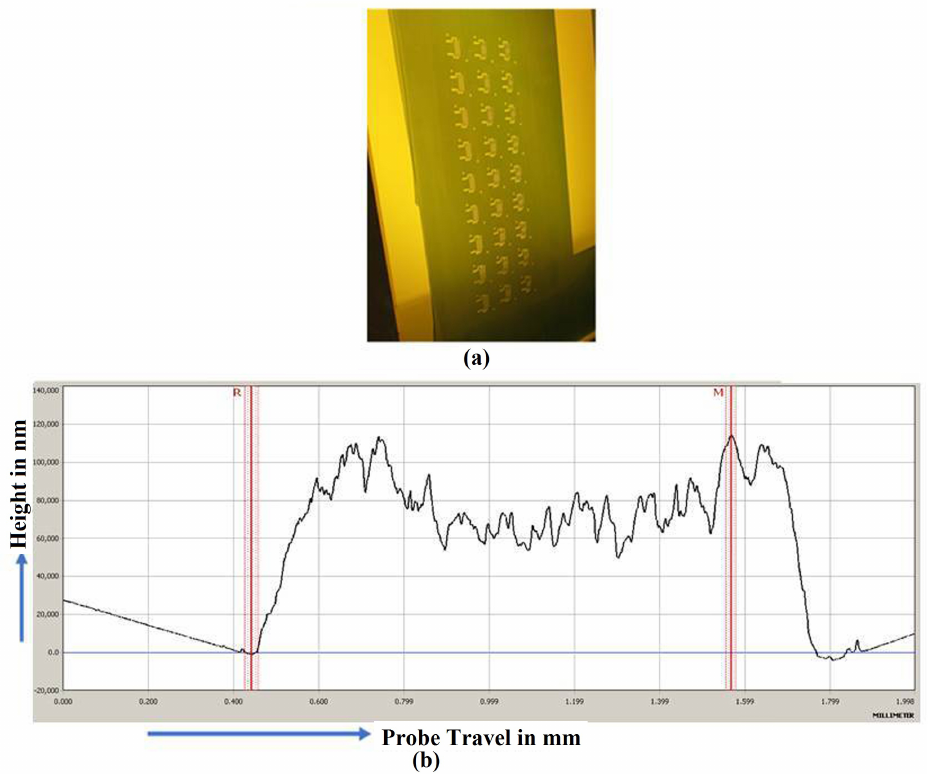
Figure 6. Fabrication and Coating measurement ( a ) Exposing in Dark room ( b ) Coating thickness chart acquired using stylus